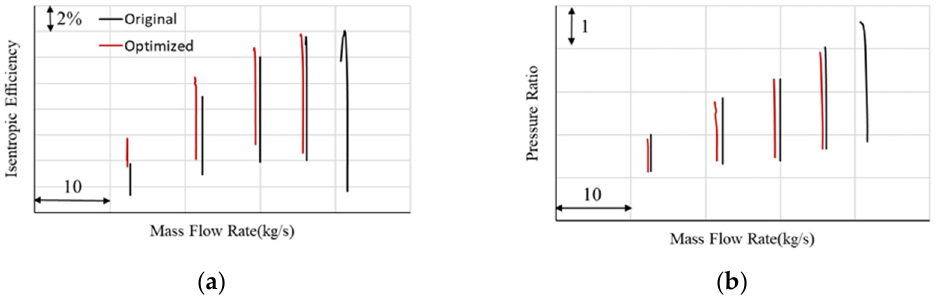
Figure 28. Performance curves of original compressor and compressor after VGV joint adjustment optimization. ( a ) Efficiency; ( b ) pressure ratio.